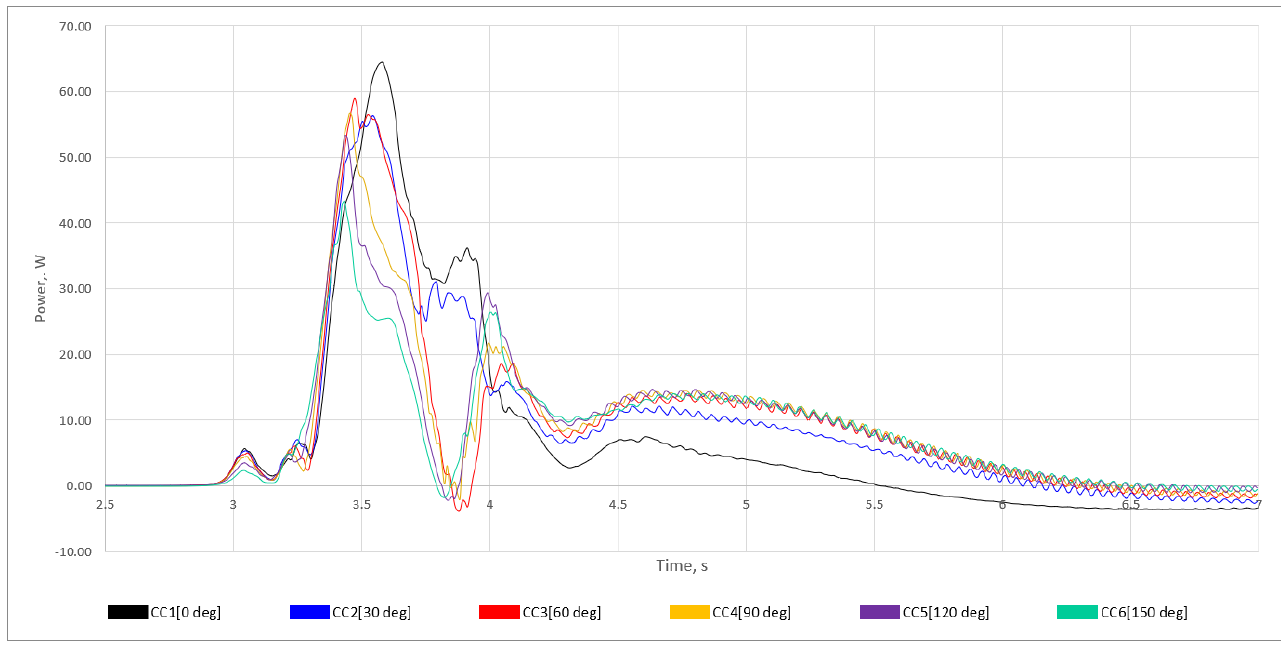
Figure 18. Instantaneous power of VAWT from Car Cases 1 to 6 (CC1 to